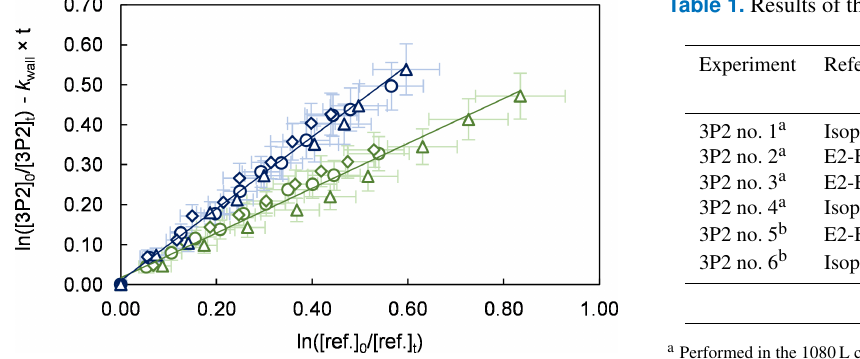
Figure 1. Relative-rate plots of all experiments using isoprene (green) and E2-butene (blue) as references. Different experimen- tal runs for each reference are denoted with different symbols. The error bars consist of a systematic uncertainty and an additional 10% relative error to cover uncertainties derived from the experimental and evaluation procedure, respectively.